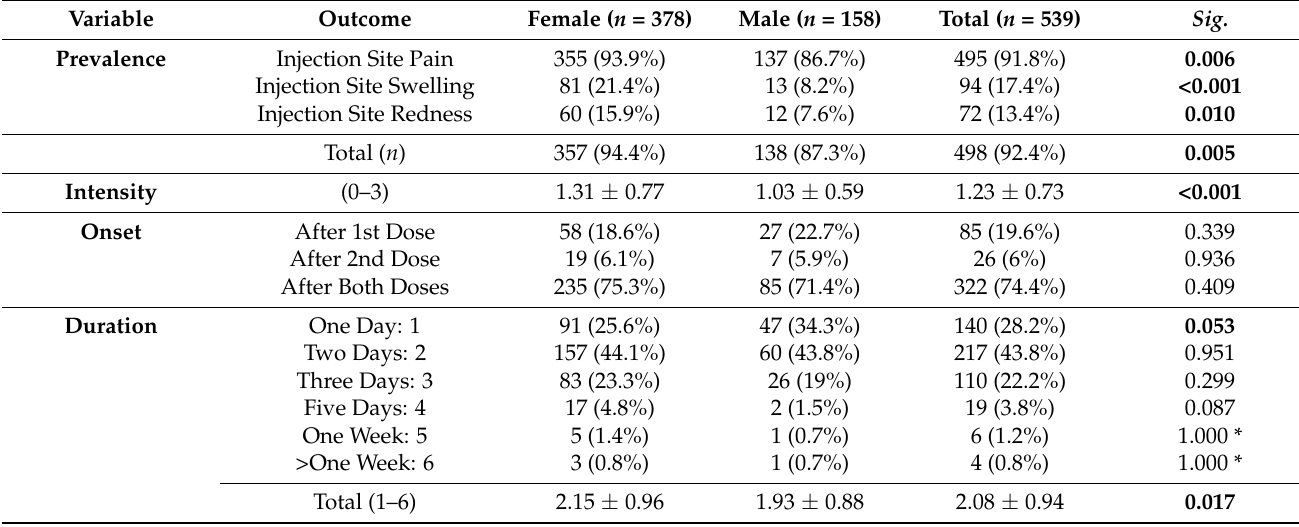
Table 3. Local side effects of young adults (18–30 years old) receiving mRNA-based COVID-19 vaccines, Czech Republic, April–June 2021 ( n =